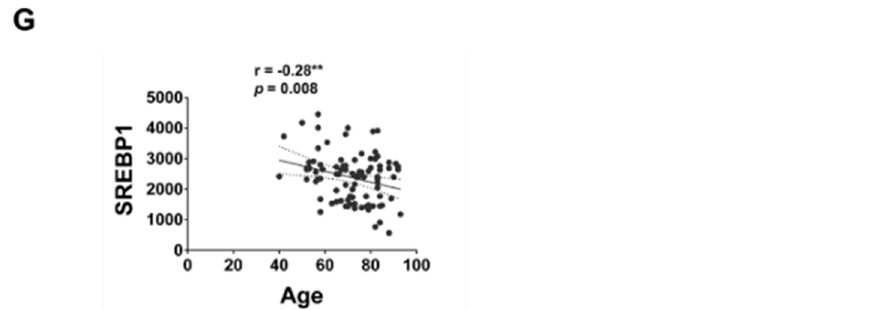
Figure 5. The correlation of expression levels of serum protein and age. Pearson’s correlation test was performed to analyze the correlation between the relative expression level of serum proteins with age for all groups of participants. A two-tailed p -value of <0.05 was considered to indicate a statistical significance. Proteins with statistically significant correlation with age was shown for ApoE ( A ), c_Myc ( B ), LATS1 ( C ), MST2 ( D ), NF κ B_p50 ( E ), PPAR γ ( F ) and SREBP1 ( G ). Asterisks *, **, *** represented a statistically significant difference of p < 0.05, p < 0.01, and p < 0.005, respec- tively.